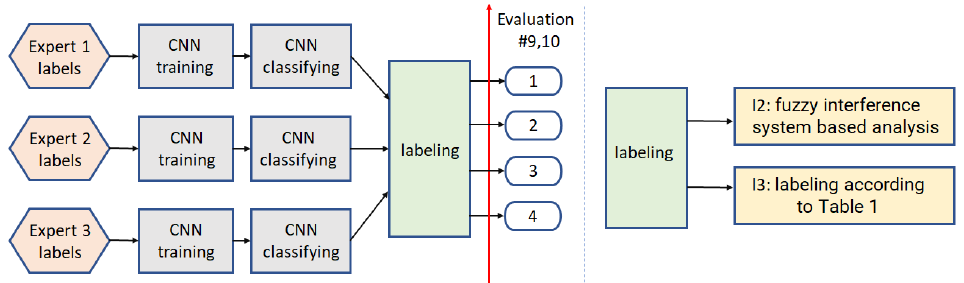
Figure 9. Multi-class analysis: Path7 and path8, utilizing two different labeling algorithms, I2 and I3,